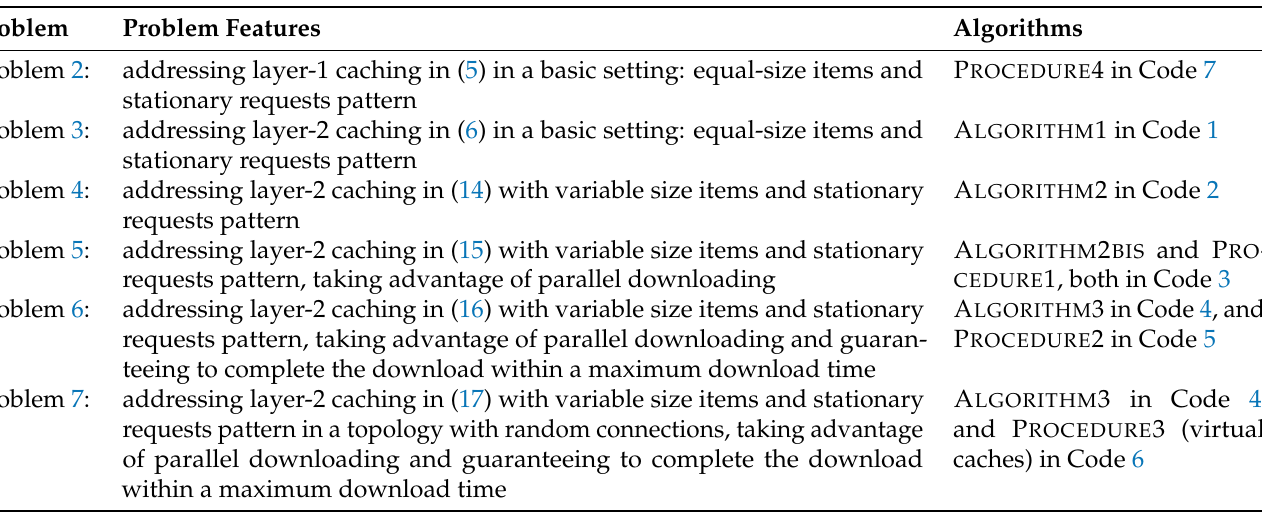
Table 2. Summary of Problems and relevant